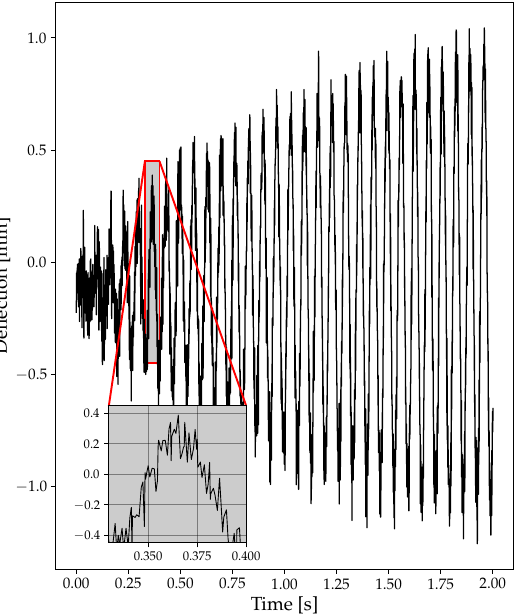
Figure 7. Example of deflection with noise: 9000 to 9500 RPM, fr = 154.2 Hz , A = 1 mm. The random noise amplitude is equal the 10% of resonance amplitude